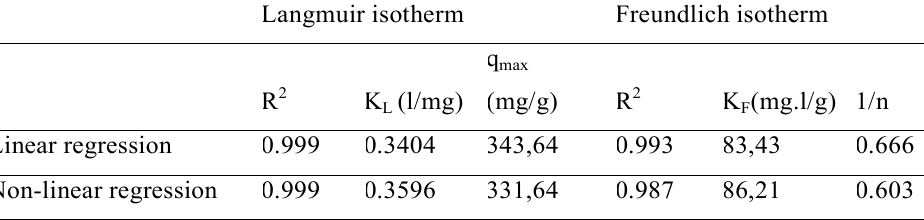
Table 3. Parameters of Langmuir and Freundlich isotherm for sorption of